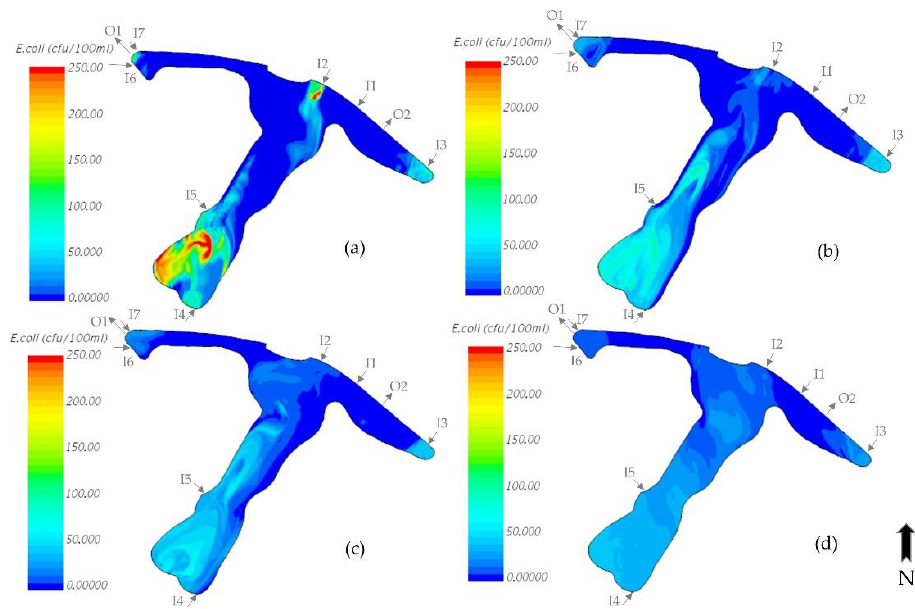
Figure 6. Contours of E. coli concentration (cfu / 100 mL) on the surface of the Inverness pond on ( a ) 26 August 2007 at 5 p.m., ( b ) 26 August 2007 at 11 p.m., ( c ) 27 August 2007 at 5 a.m., and ( d ) 27 August 2007 at 11 a.m.